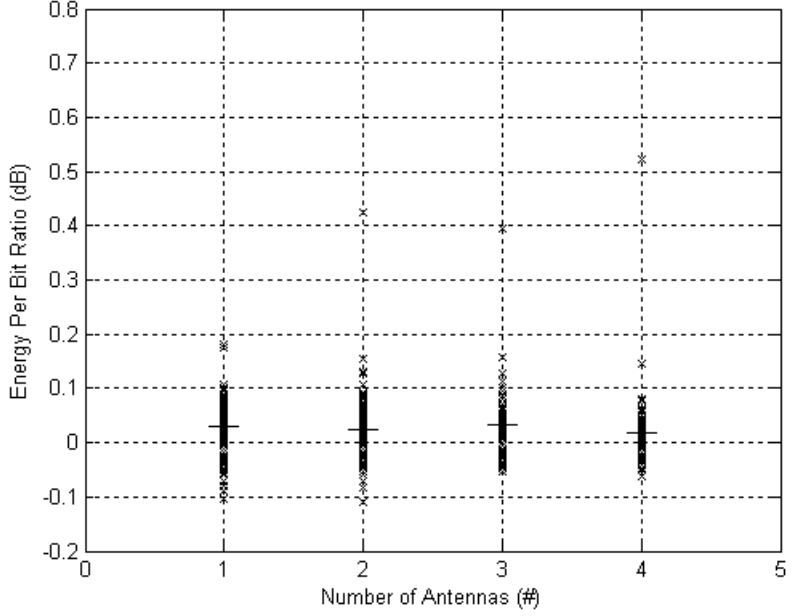
Figure 12. Increase in Energy per Bit for M = 100 vs. M = 0 and varying number of antennas at the off-body access point. The straight horizontal lines depicts the mean